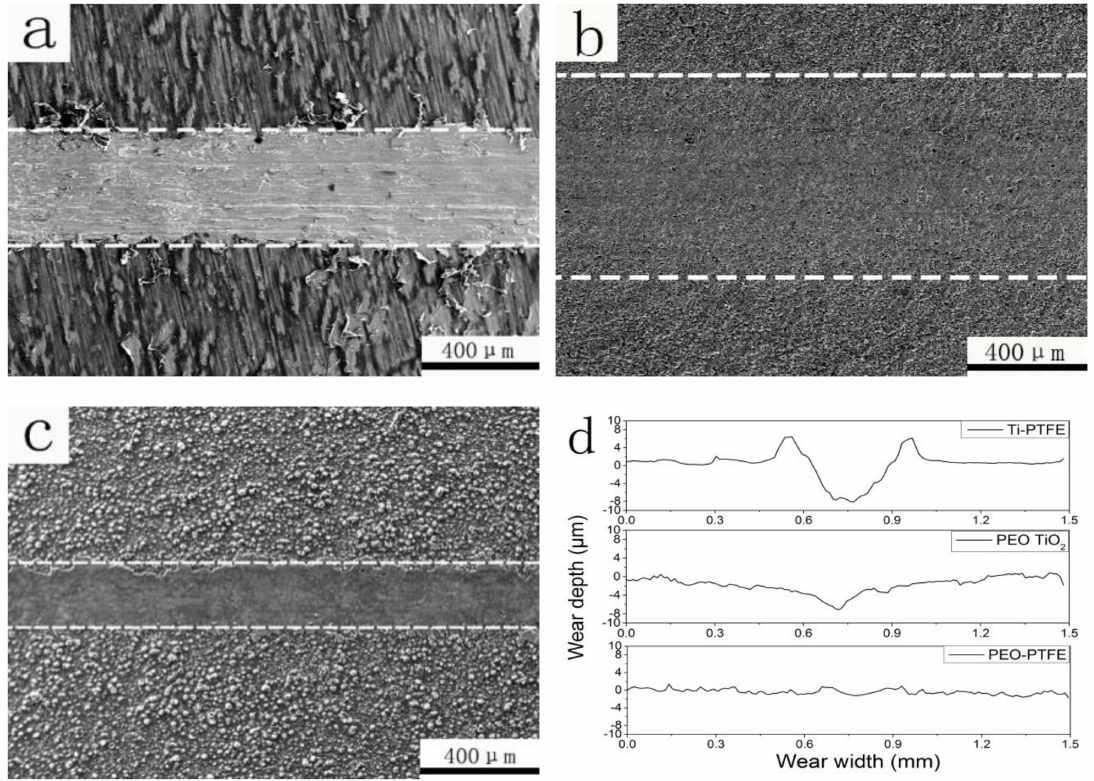
Figure 7. Scanning electron microscope (SEM) images and cross-sectional profiles of wear tracks after a sliding distance of 100 m under the 4 N load of the ( a ) Ti-PTFE coating; ( b ) PEO TiO 2 coating; ( c ) PEO–PTFE composite coating; and ( d ) cross-sectional profiles of wear